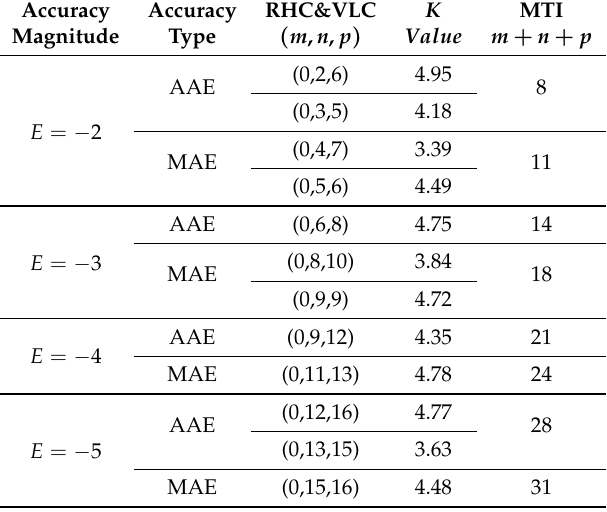
Table 4. Tanh: The Corresponding Relationship between the Magnitudes of Accuracy and Iterations. Accuracy